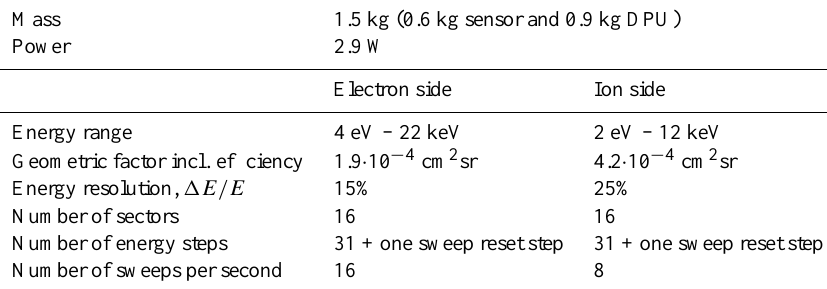
Fig. 6. Auroral emissions over eastern Siberia and Alaska. This image was made using data from PIA-2, channel A, during the time period 12:40–12:55 UT on 18 December 1998. Also shown is an enlarged version of the same event. The satellite moved from west to east. The change in background intensity, seen as a line across the image, is due to the satellite entering eclipse, where the background noise is considerably lower. Table 1. MEDUSA instrument